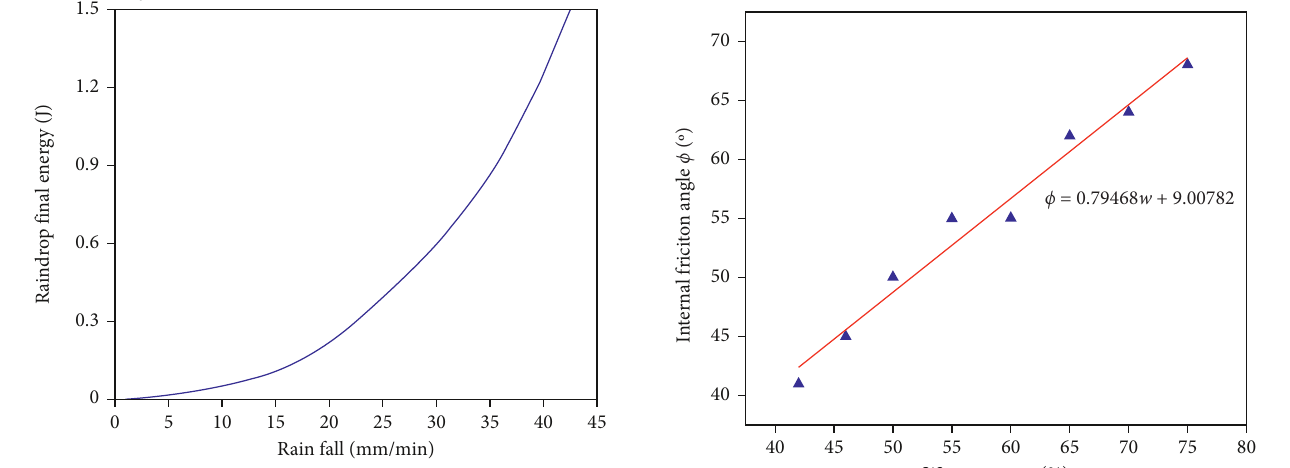
Figure 5: Relationship between precipitation and raindrop energy.